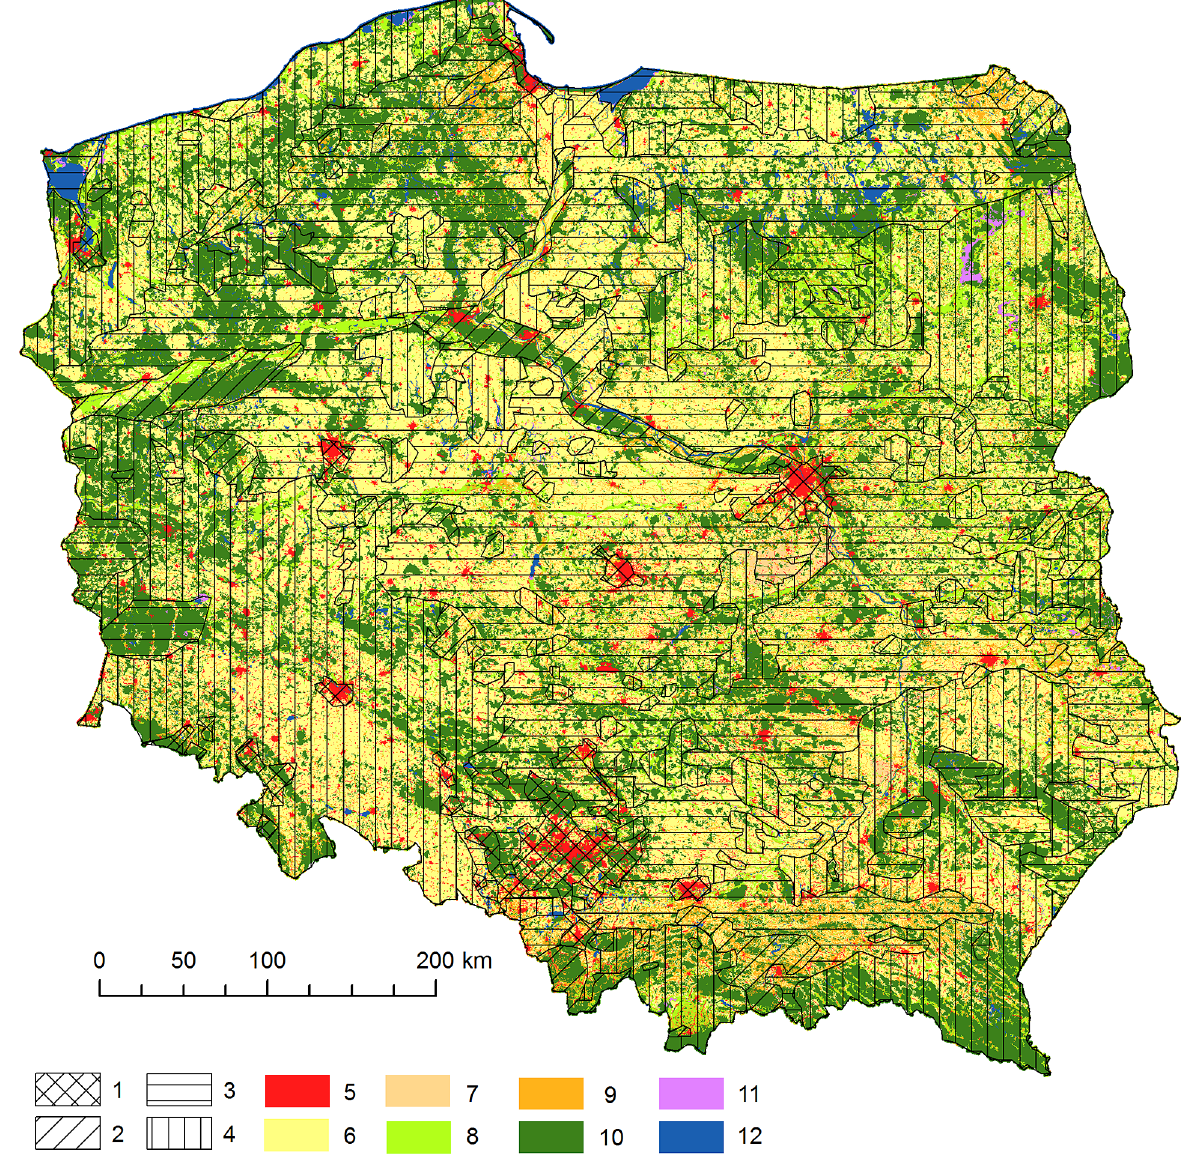
Fig. 2. Spatial diversity of rural landscape types in terms of settlements types and land cover on the basis of corine land cover 2006, kiełczewska-zalewska (1965) and Szymańska (2009) (author’s generalization). 1 – landscapes of urban settlements; 2 – landscapes of rural settlements primary distributed, with the lowest degree of concentration, in swamps, sandrs and secondary distributed; 3 – mixed landscape of rural settlements with a dash distributed; 4 – landscape of rural settlements – focused, with elongated buildings and with a predominance of linear settlement; 5 – artificial surfaces; 6 – arable land; 7 – permanent crops; 8 – pastures; 9 – heterogeneous agricultural areas; 10 – forest and seminatural areas; 11 – wetlands; 12 – water